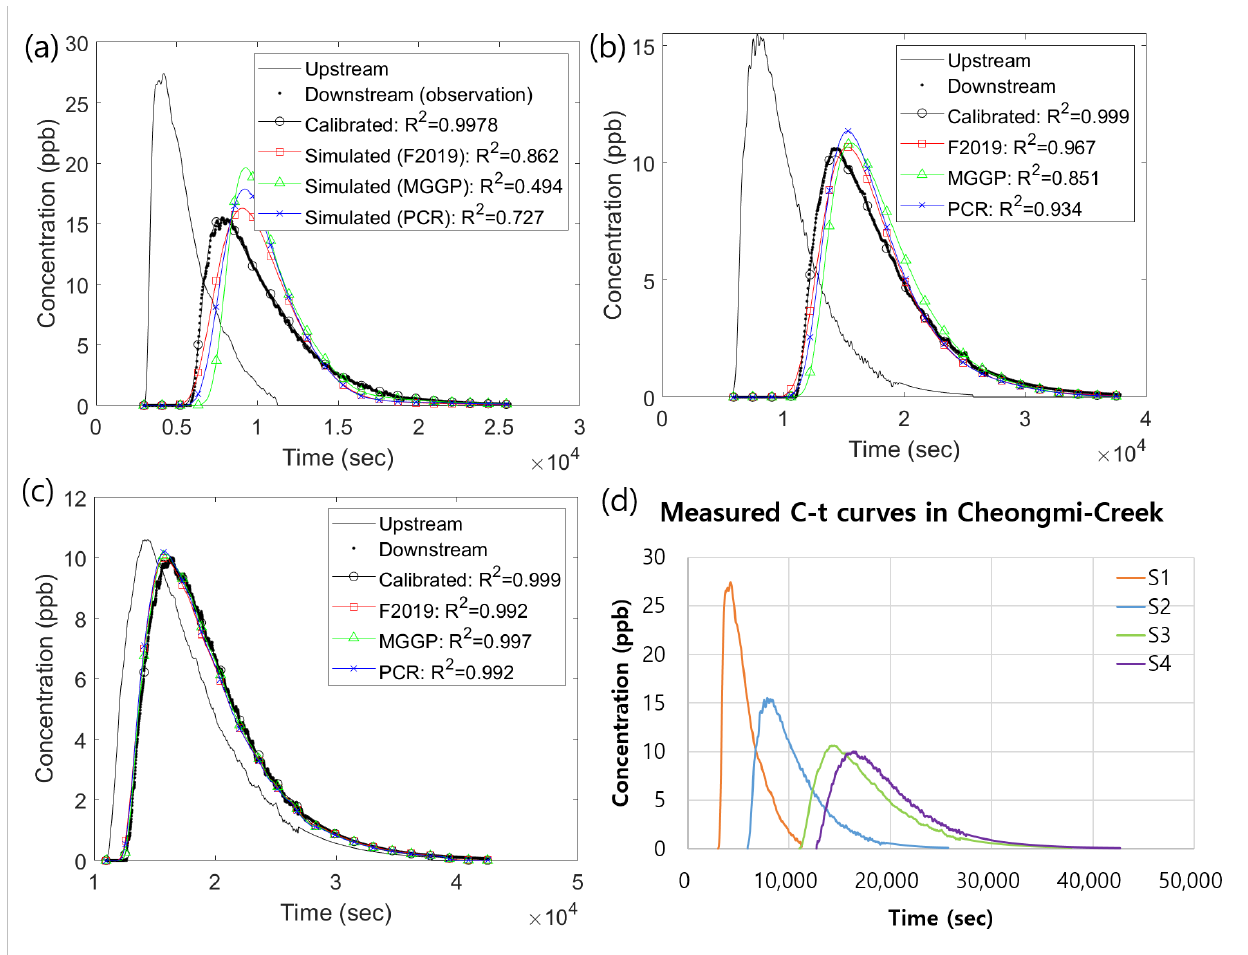
Figure 15. Simulated and observed breakthrough curves in Cheongmi Creek experiment case: ( a ) section 1–2. ( b ) section 2–3. ( c ) section 3–4. ( d ) All stations (only measured